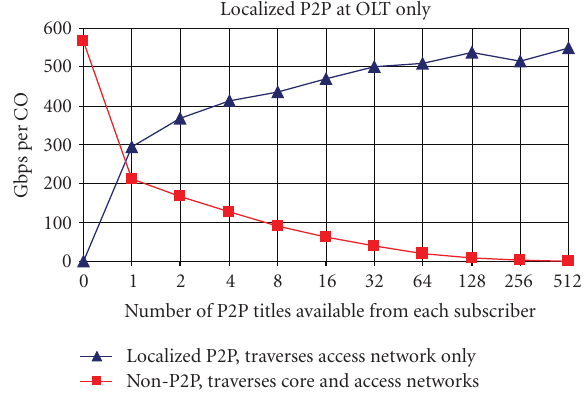
Figure 7: Localized versus non-localized unicast video bandwidth. P2P hairpins at the OLT chassis or OLT port. Customers on the same OLT can share local P2P video. NG-PON.